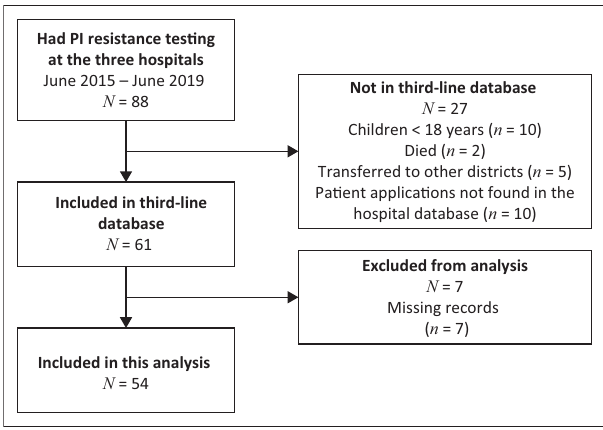
FIGURE 2: Overall delay to initiation of third-line antiretroviral therapy (TLART) and stratification of delays showing median time (days) from the date the